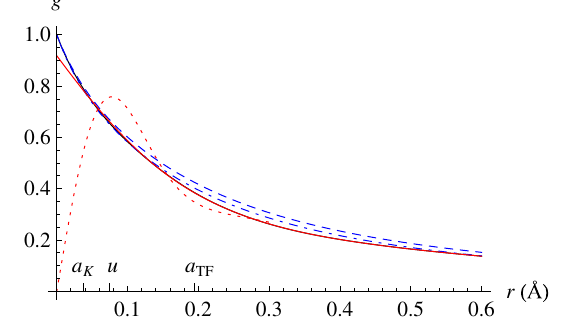
FIG. 4. Screening function parametrizations for an isolated silicon atom. Black solid curve, Lobato-Van Dyck potential (90). Red solid, f -based Doyle-Turner potential (87). Red dotted, f X based Doyle-Turner potential (86). Black dashed, Moli`ere po- tential (80). Black dot-dashed, Moli`ere potential (80) with modified screening radius (84). The axis ticks show characteristic atomic scales, such as the K-shell radius a Thomas-Fermi radius (81), as well as the rms atom thermal displacement in a solid state